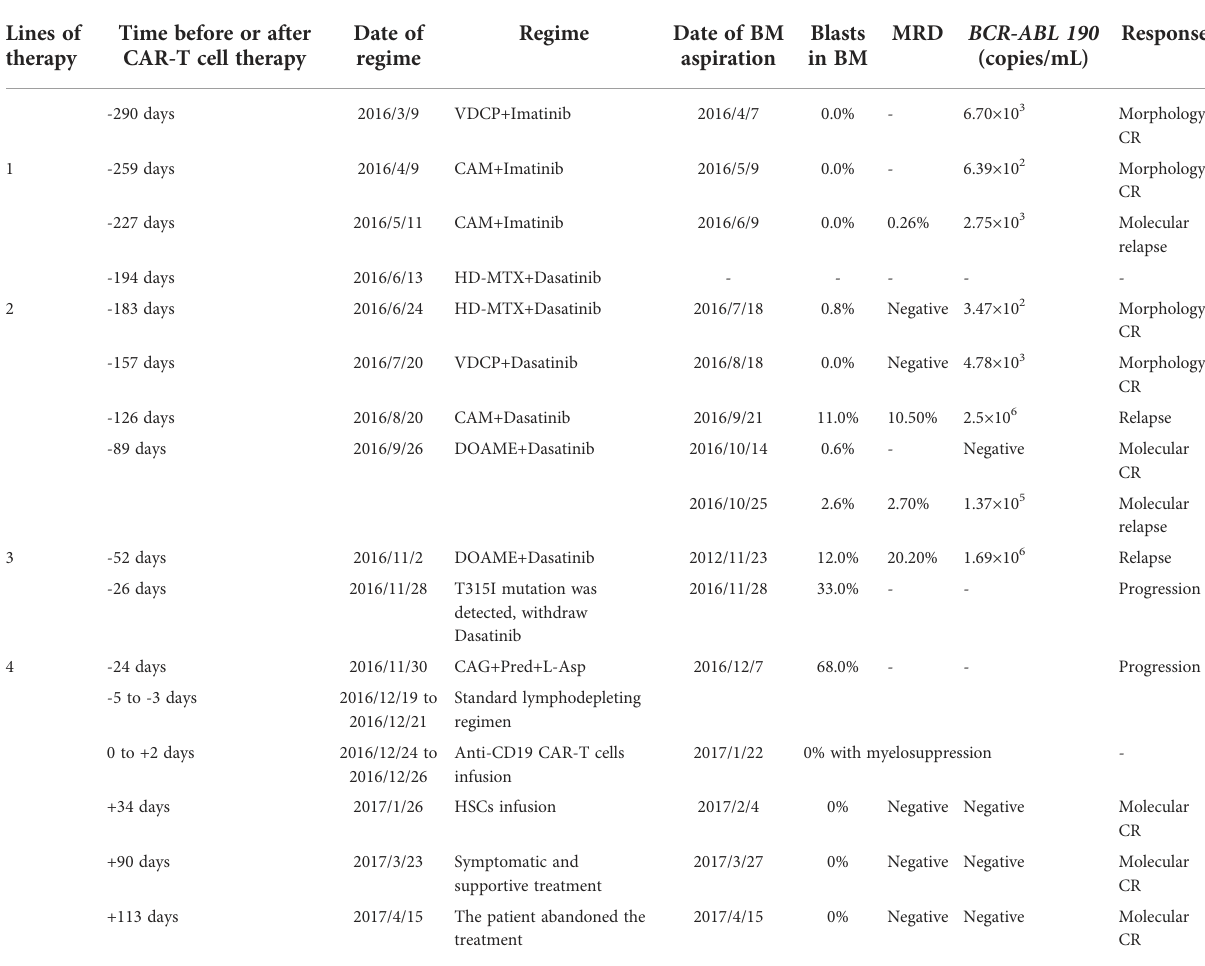
TABLE 1 Key clinical events in this case. Lines of Time before or after therapy CAR-T cell